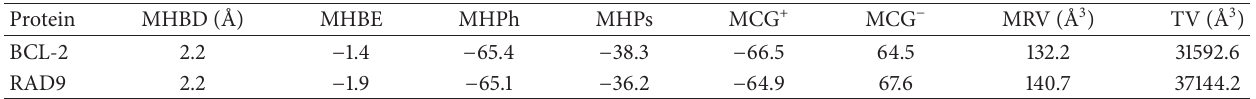
Table 1: Structural parameters of the model.